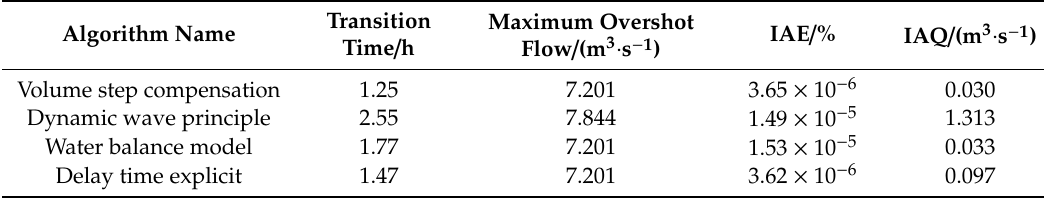
Table 3. Performance indicators of canal